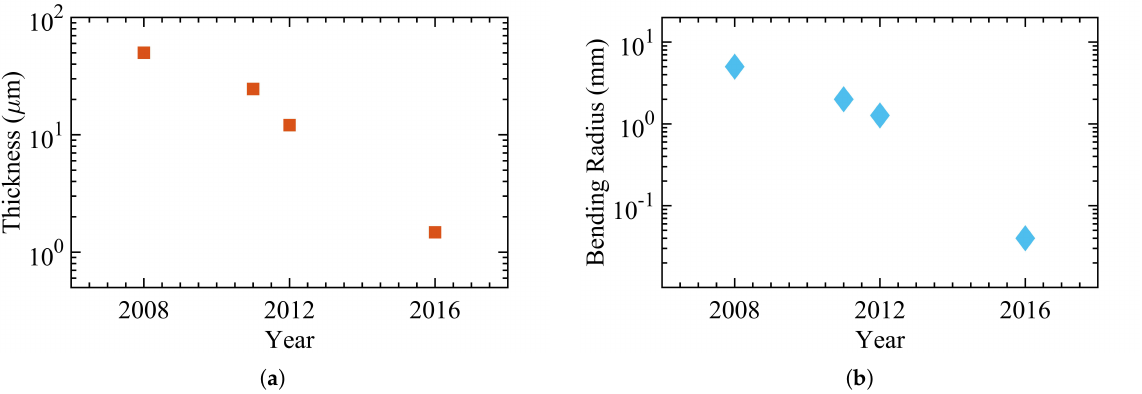
Figure 9. The progress of SWCNT TFTs with ( a ) the total thickness and ( b ) the bending radius.